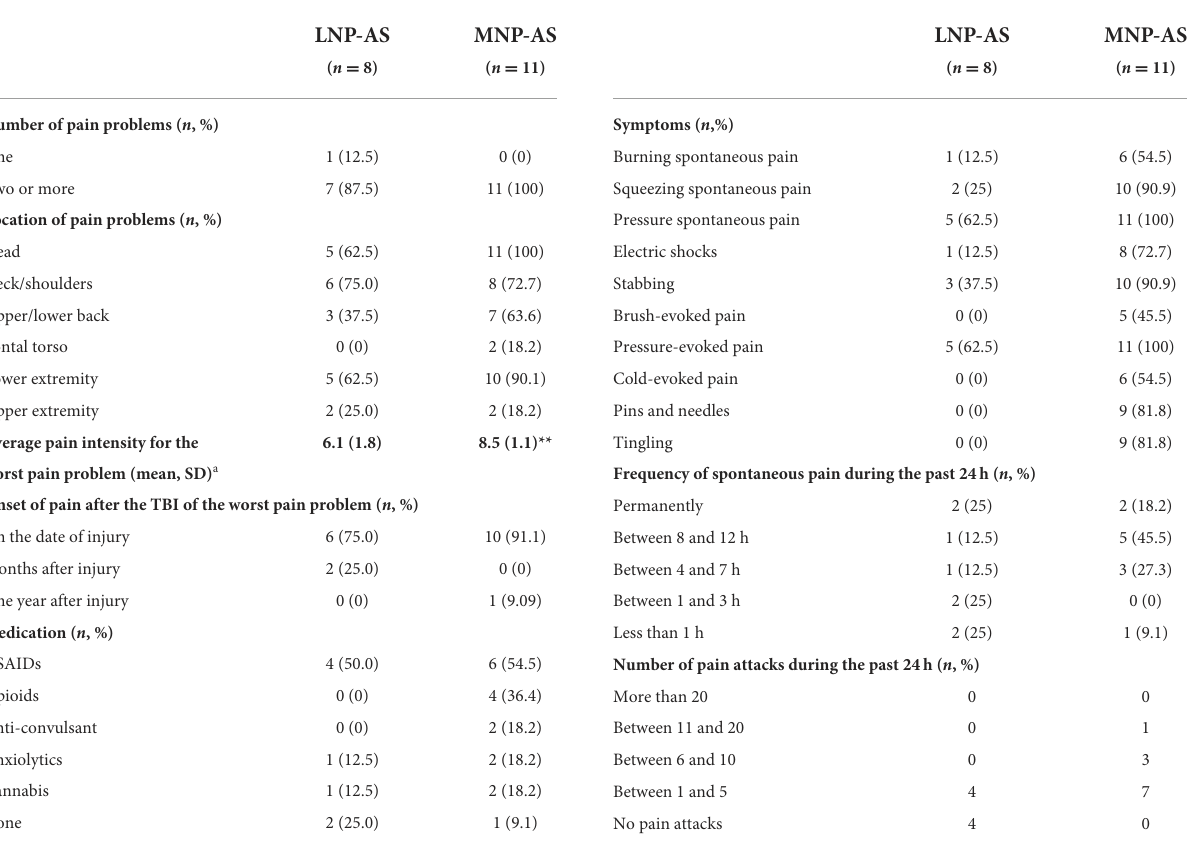
TABLE 2 Chronic pain characteristics and medication. TABLE 3 Neuropathic pain